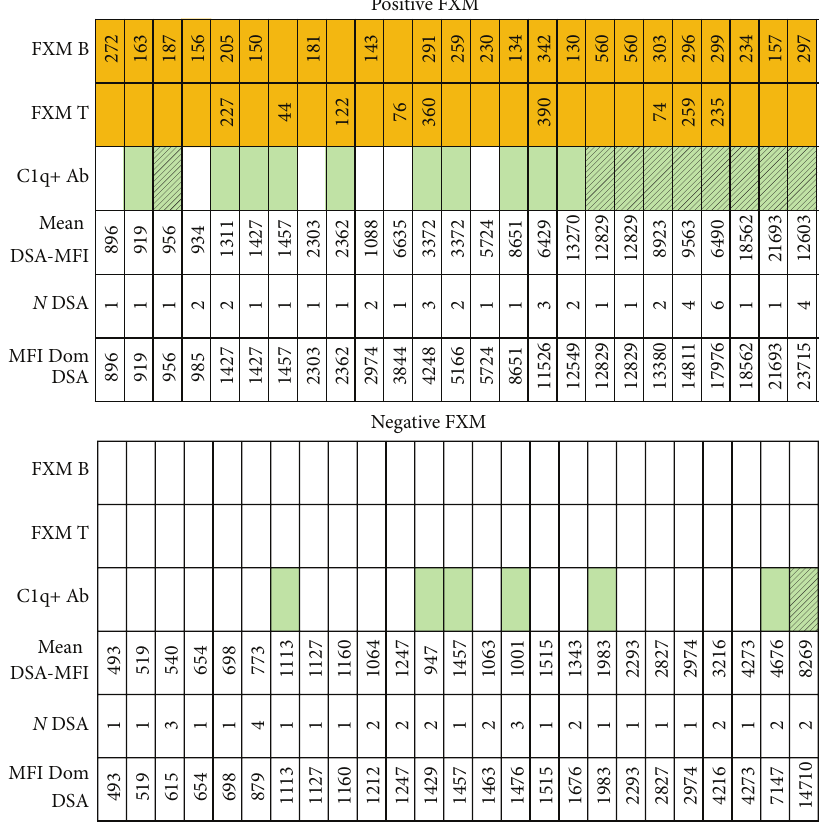
Figure 5: Characteristics of DSA and FXM results. The first two lines show B cell and T cell channel shift results for each positive FXM test; the next line depicts complement fixing HLA-Abs (C1q+ in filled cells) where a dashed square mark indicates DSA C1q+. The next three lines show the mean DSA-SAB MFI, number of DSA, and dominant DSA-SAB MFI. MFI = mean fluorescence intensity, DSA = donor-specific antibodies, 𝑁 = number, C1q+ HLA-Abs = C1q positive HLA antibodies, and FXM = flow